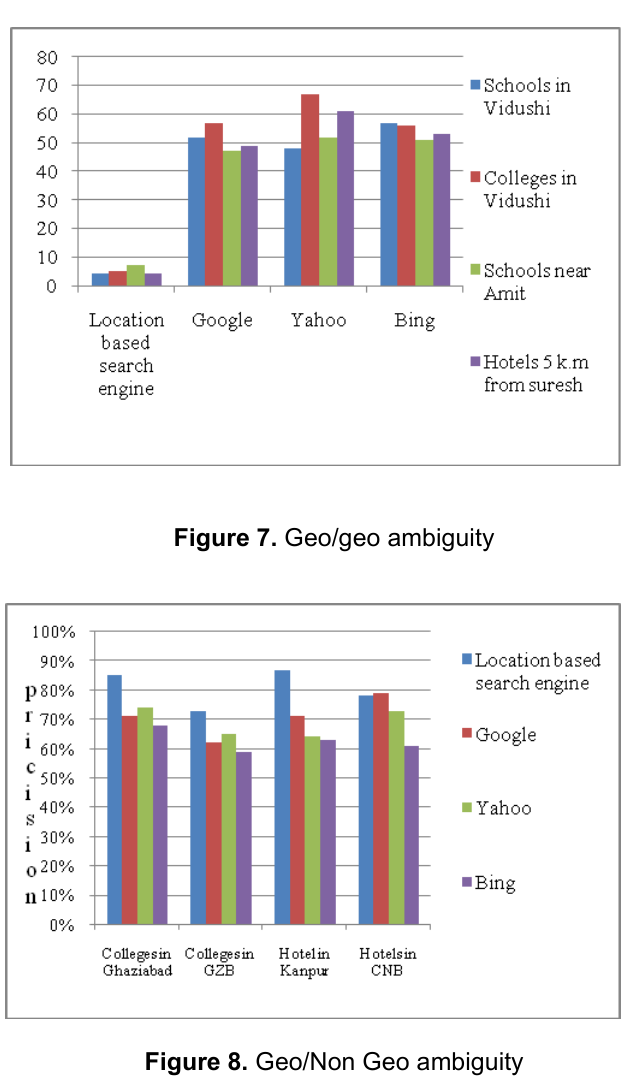
Figure 8. Geo/Non Geo